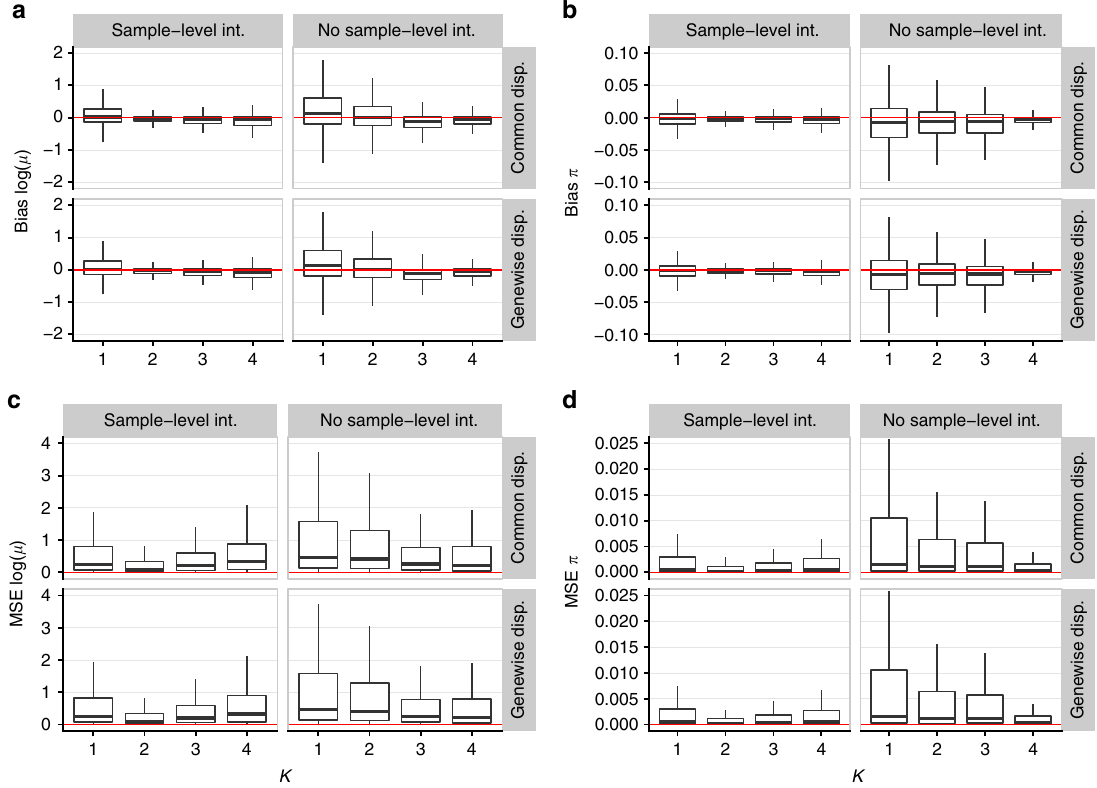
Fig. 6 Bias and MSE for ZINB-WaVE estimation procedure. Panels show boxplots of a bias ln( μ ), b bias π , c MSE ln( μ ), and d MSE π for ZINB-WaVE estimation procedure, as a function of the number of unknown covariates K . ZINB-WaVE was fi t with X = 1 n , common/genewise dispersion, and with/ without sample-level intercept (i.e., column of ones in gene-level covariate matrix V ). For each gene and cell, bias and MSE were averaged over B = 10 data sets simulated from our ZINB-WaVE model, based on the S1/CA1 data set and with n = 1000 cells, J = 1000 genes, scaling of one for the ratio of within to between-cluster sums of squares ( b 2 = 1), K = 2 unknown factors, zero fraction of about 80%, X = 1 n , cell-level intercept ( V = 1 J ), and genewise dispersion. The lower and upper hinges of the boxplots correspond to the fi rst and third quartiles (the 25th and 75th percentiles), respectively. The upper/lower whisker extends from the hinge to the largest/smallest value no further than 1.5 × IQR from the hinge (where IQR is the inter-quartile range or difference between the third and fi rst quartiles). Data beyond the whiskers are called outliers and are not plotted here. Supplementary Fig. 24 provides the